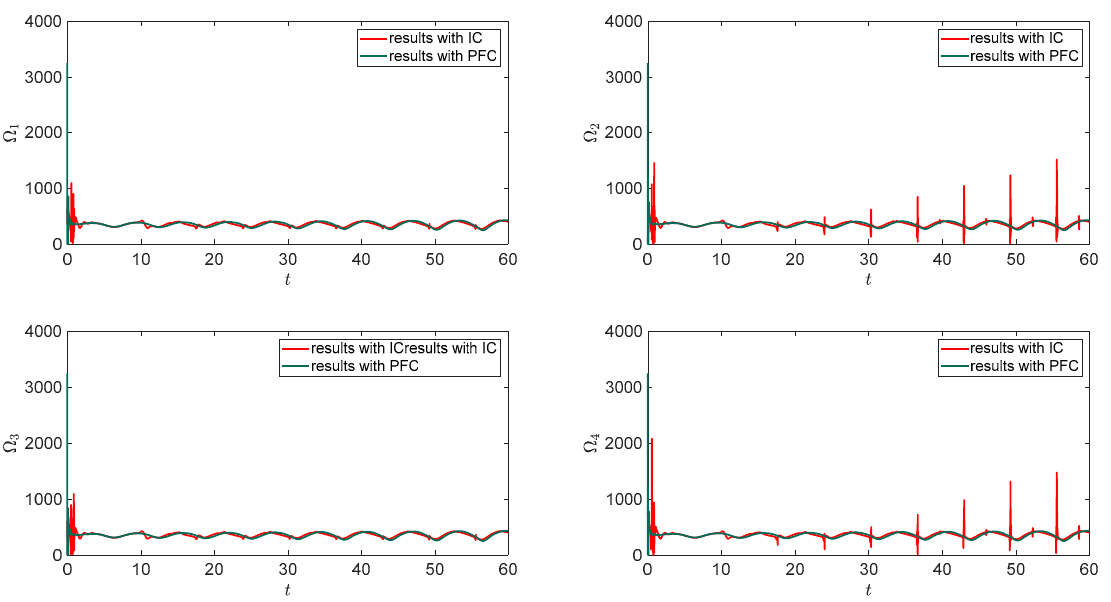
Figure 10. Comparison of control signals between proposed fractional order controller (PFC) and integer order controller (IC).